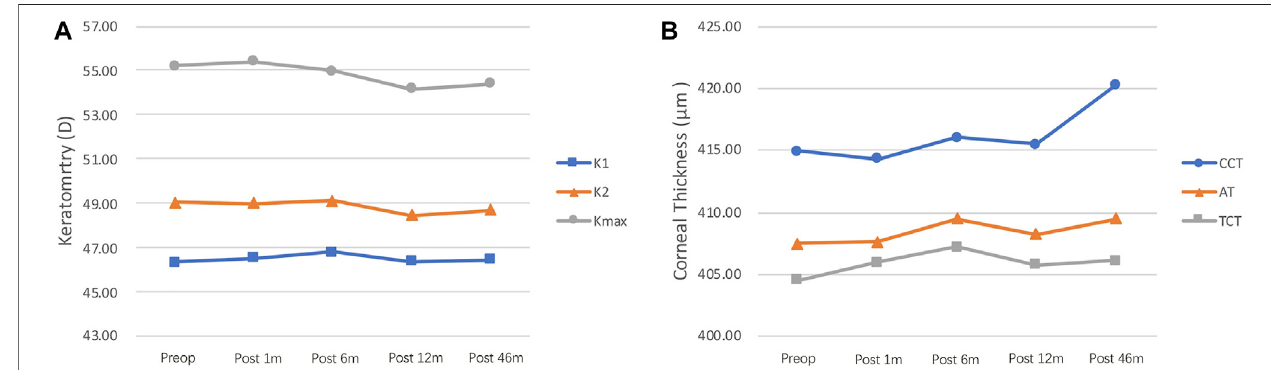
FIGURE1|(A) K max , K1, and K2 valuesat differentfollow-uptime points. No signi fi cantchangeswereobservedin K max , K1, and K2 during the46-months follow- up( p > 0.05).K max ,maximumkeratometry;K1,steepestmeridiankeratometry;K2, fl attestmeridiankeratometry. (B) CCT,AT,andTCTvaluesatdifferentfollow-uptime